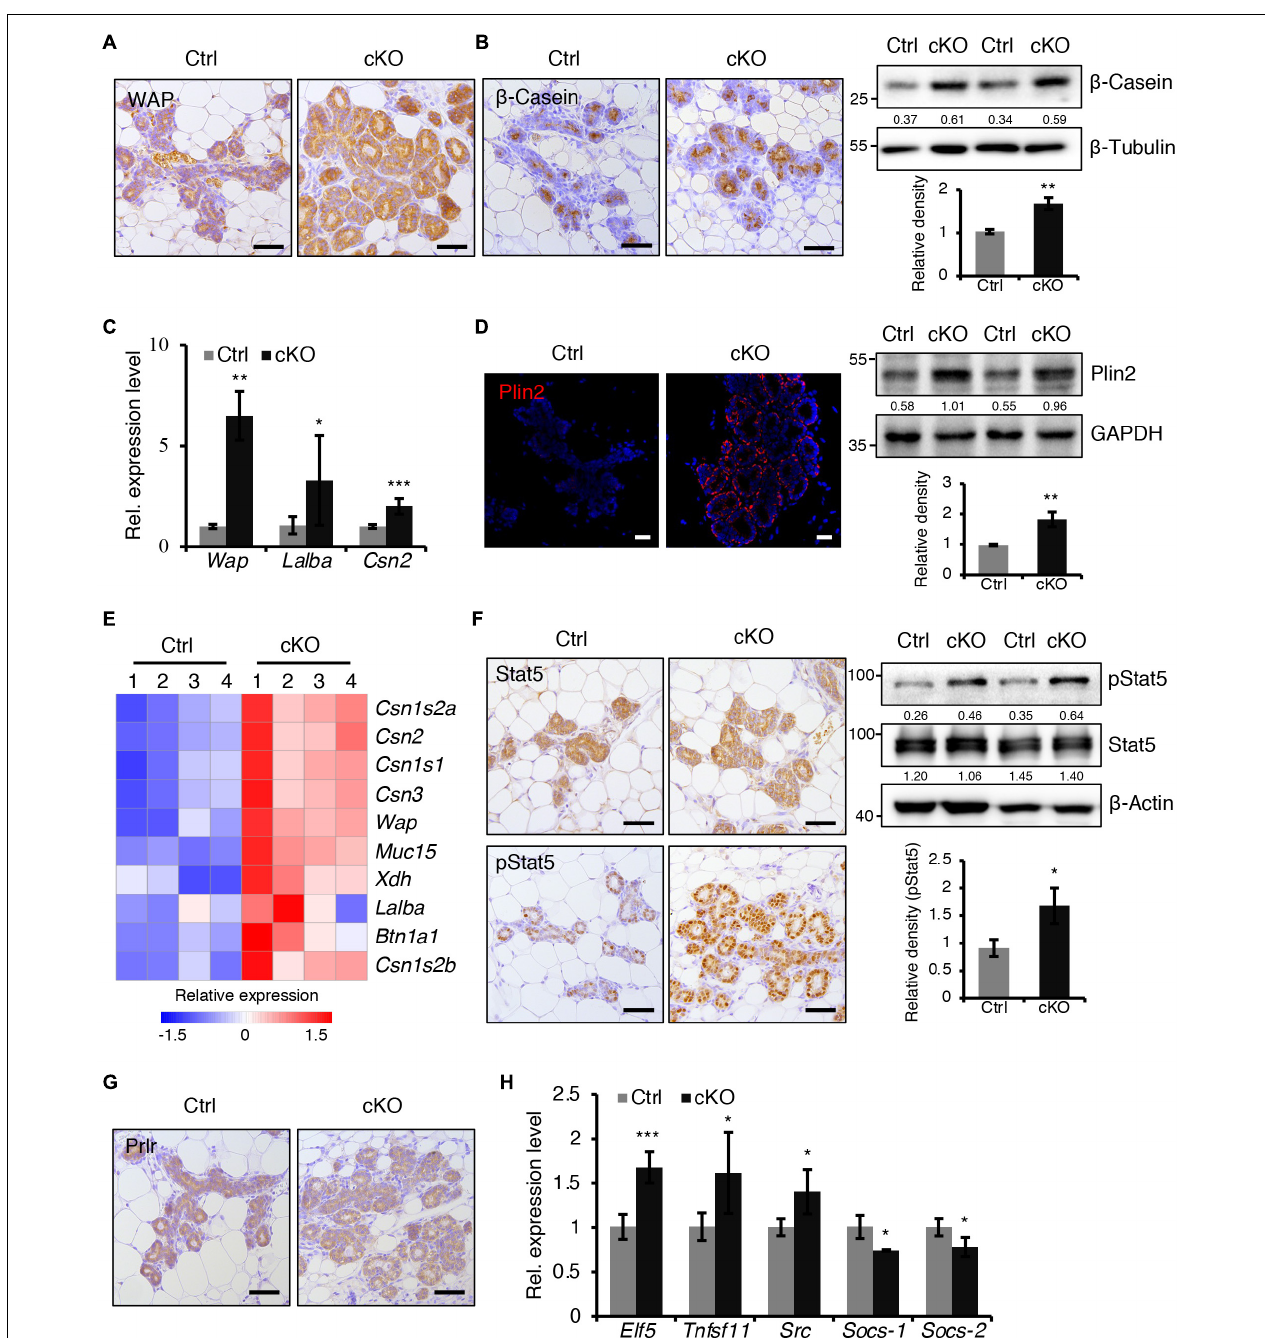
FIGURE 3 | BMPR1a deficiency resulted in precocious alveolar differentiation during pregnancy. (A) Immunohistochemistry staining for WAP in control and cKO mammary glands at pregnancy day 14.5. n = 3 mice per group. Scale bar, 50 µ m. (B) Immunohistochemistry staining and western blotting for β -Casein in control and cKO mammary glands at pregnancy day 14.5. n = 3 mice per group. β -Tubulin was used as a loading control. Scale bar, 50 µ m. Statistical analysis the expression of β -Casein/ β -Tubulin. n = 3 mice. (C) qRT-PCR analysis of Wap , Lalba and Csn2 in mammary epithelial cells isolated from control and cKO mice at pregnancy day 14.5. n = 4–6 biological replicates. (D) Immunofluorescence staining and western blotting for Plin2 in control and cKO mammary glands at pregnancy day 14.5. n = 3 mice per group. GAPDH was used as a loading control. Scale bar, 25 µ m. Statistical analysis the expression of Plin2/GAPDH. n = 3 mice. (E) Heatmap for milk protein-related gene expression in control and cKO mammary glands at pregnancy day 14.5. n = 4 mice per group. (F) Immunohistochemistry staining and western blotting for Stat5 and pStat5 in control and cKO mammary glands at pregnancy day 14.5. n = 3 mice per group. β -Actin was used as a loading control. Scale bar, 50 µ m. Statistical analysis the expression of pStat5/ β -Actin. n = 3 mice. (G) Immunohistochemistry staining for Prlr in control and cKO mammary glands at pregnancy day 14.5. n = 3 mice per group. Scale bar, 50 µ m. (H) qRT-PCR analysis of Elf5, Tnfsf11, Src, Socs-1, and Socs-2 in mammary epithelial cells isolated from control and cKO mice at pregnancy day 14.5. n ≥ 3 biological replicates. Data were presented as means ± SD. ∗ p < 0.05, ∗∗ p < 0.01, ∗∗∗ p < 0.001.